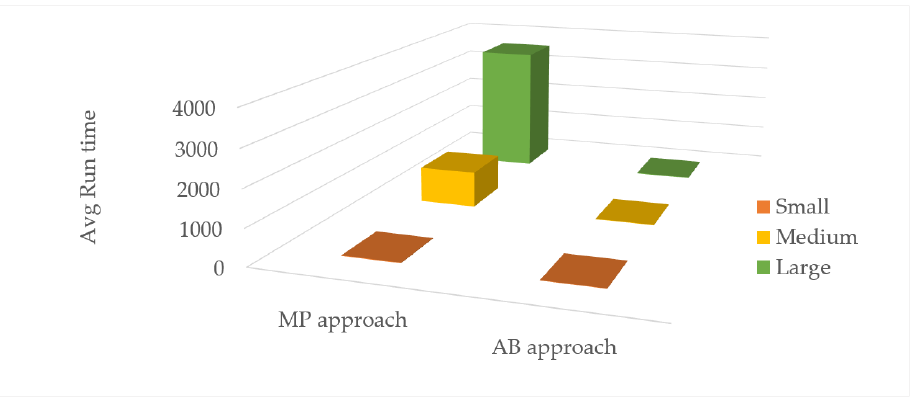
Figure 6. Average Run time for small, medium, and large instances for MP and AP approach.